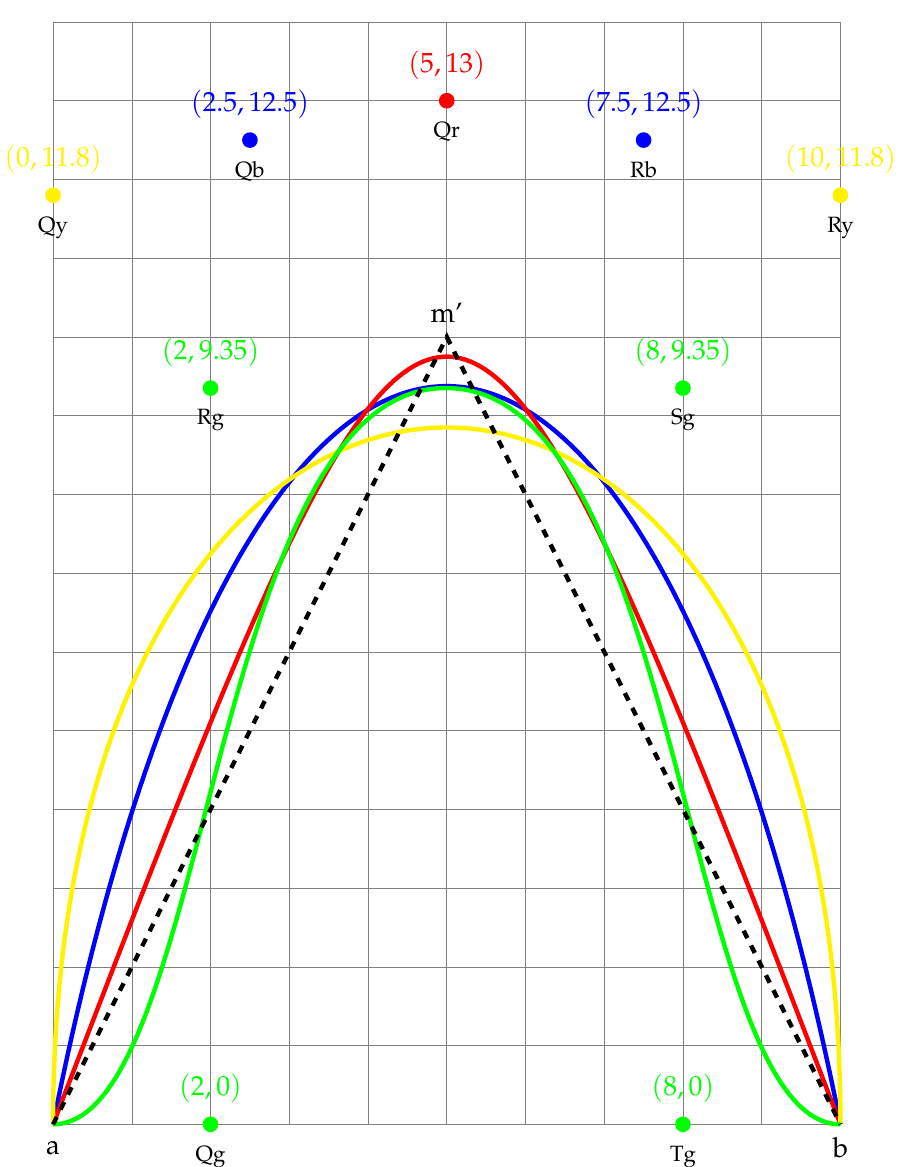
Figure A3. Several graphical solutions to the constraint of drawing an edge with a given length between cities a and b : Two straight segments (dotted) and different Bézier curves (red with one control point Qr ; blue with two control points Qb and Rb ; yellow with two control points Qy and Ry ; and green with four control points Qg , Rg , Sg , and Tg ). The position of control points was adjusted to constrain the curve